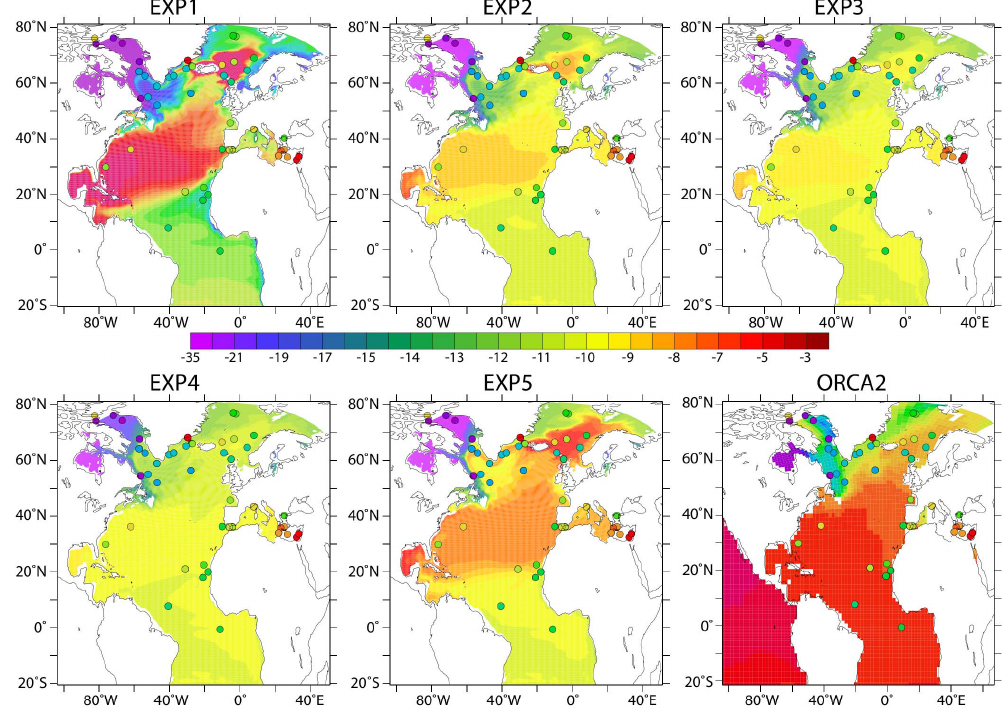
Fig. 2. 100m-depth ε Nd distribution map, for the 5 simulations performed using the model in NATL4 configuration. EXP1: A map of the ε Nd distribution at the same depth, from a previous simulation using the global ORCA2 configuration, with a relaxing time of 1 year, is also shown. Superimposed circles represent the data between 50 and 300m depth. Color scale is the same for both simulation output and data, and is nonlinear. Data are issued from Piepgras and Wasserburg (1980, 1983, 1987), Stordal and Wasserburg (1986), Spivack and Wasserburg (1988), Tachikawa et al. (1999), Lacan and Jeandel (2004a,b,c, 2005a,b), Dahlqvist and Andersoon (2005) and Rickli et al. (2009) and compiled by F. Lacan and K. Tachikawa (available here: http://www.legos.obs-mip.fr/fr/equipes/geomar/results/database may06.xls).